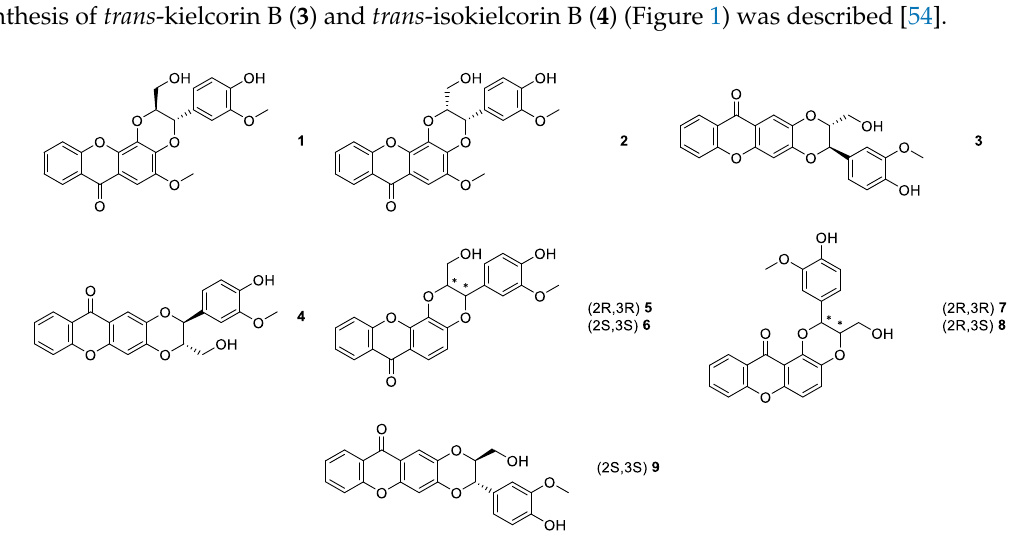
Figure 1. Structures of kielcorin ( 1 ) and synthetic derivatives 2 – 9 .